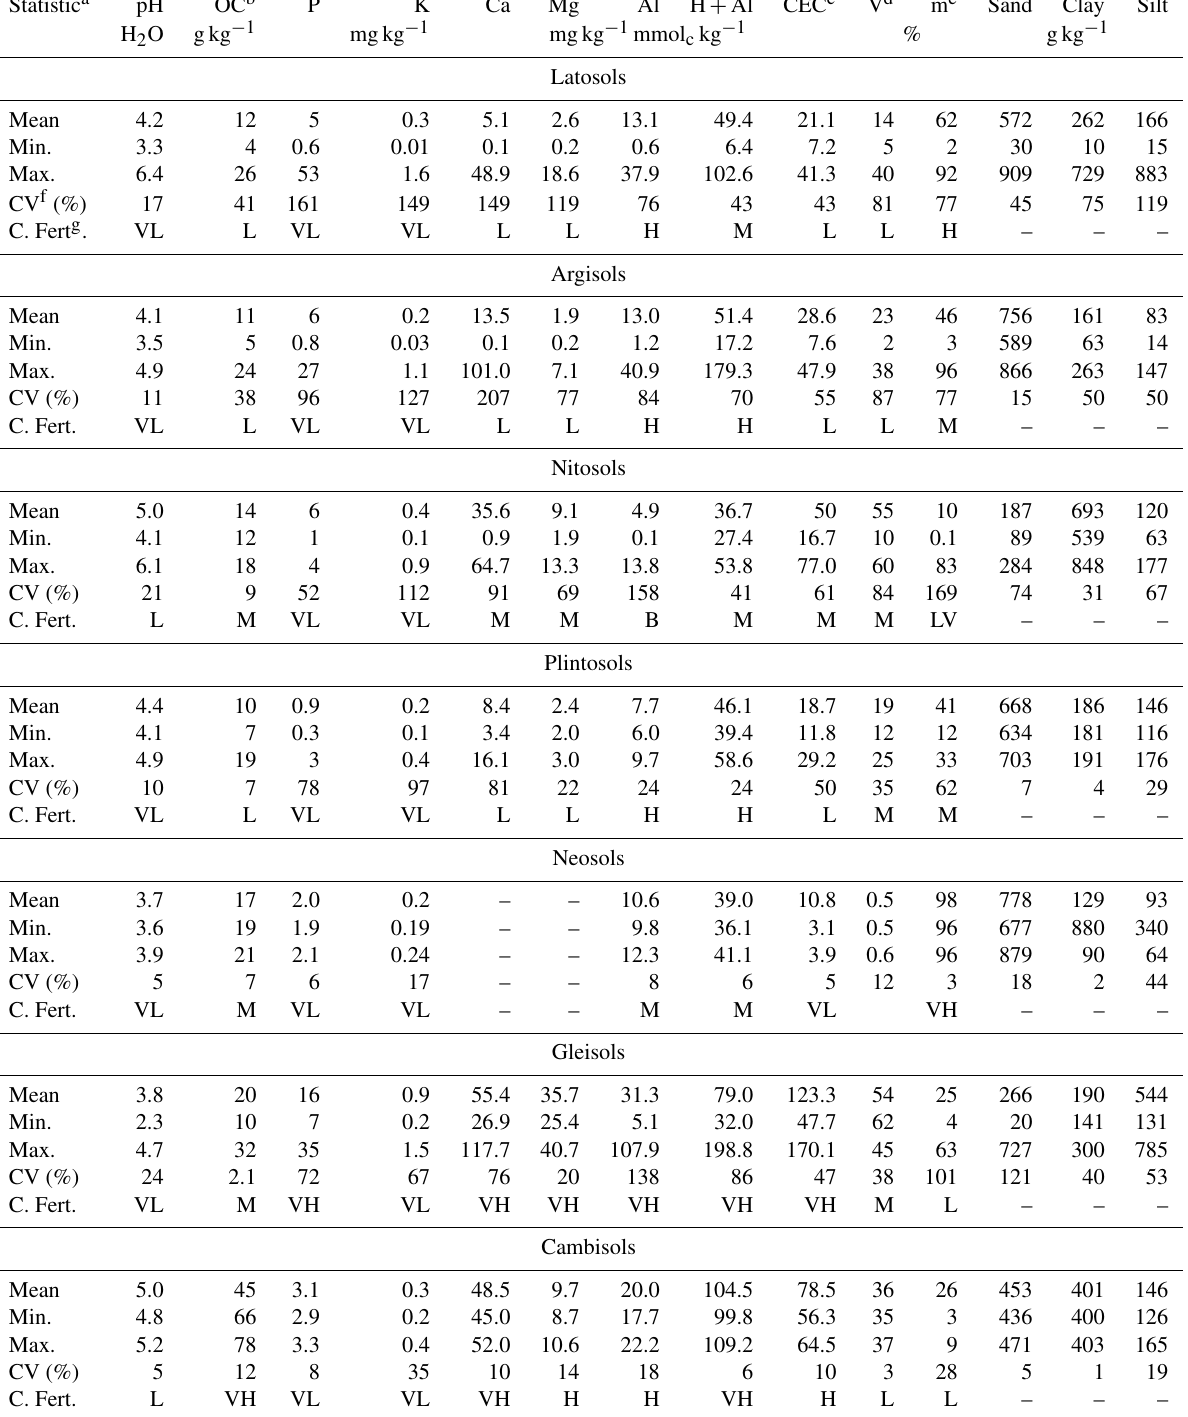
Table 1. Physical and chemical properties of the surface layer of soil in the state of Pará. Statistic a pH